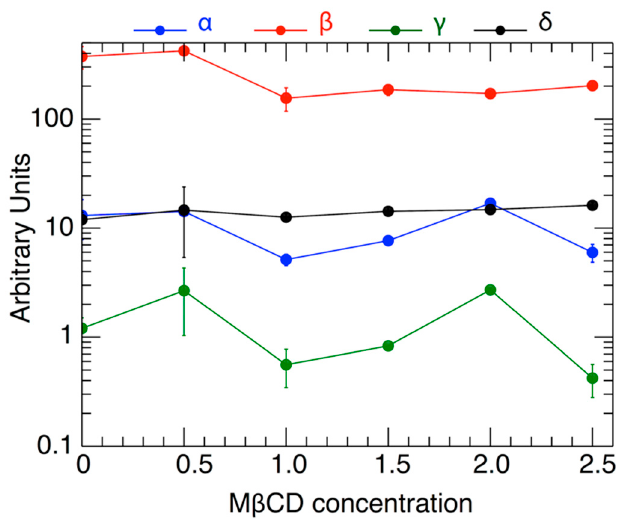
Figure 5. The values of the parameters α , β , γ , δ , and their standard deviations, as shown in Table 4, plotted against the respective values of the MßCD concentration (the latter’s standard deviations are not plotted).